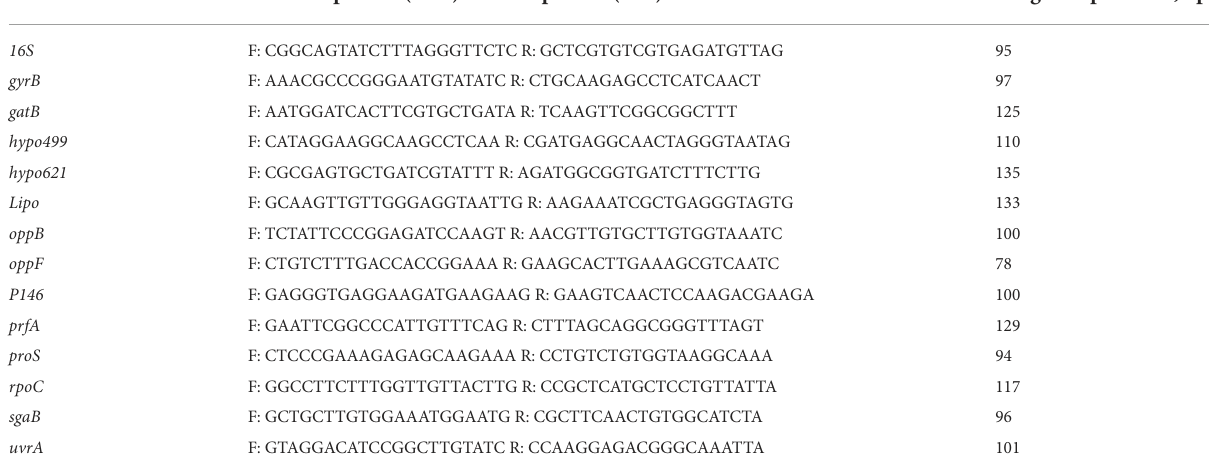
TABLE 2 RT-qPCR primers for candidate reference genes.